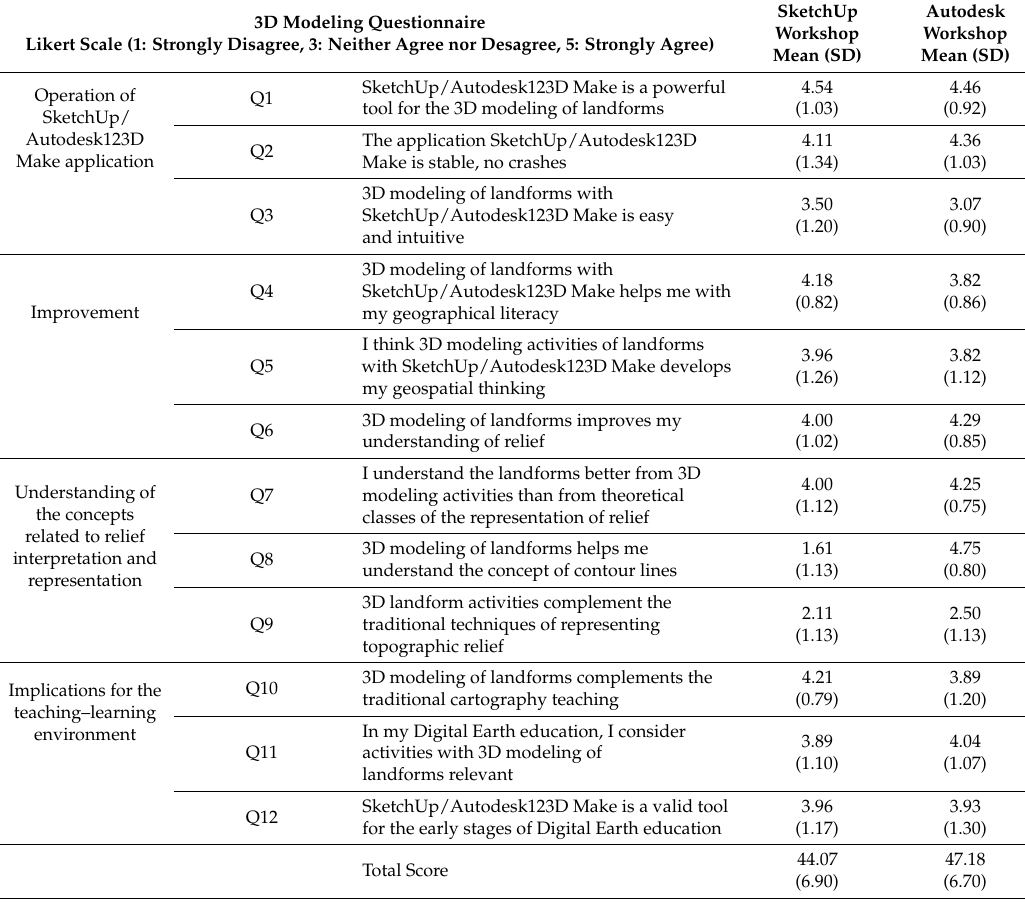
Table 3. 3D modeling questionnaire